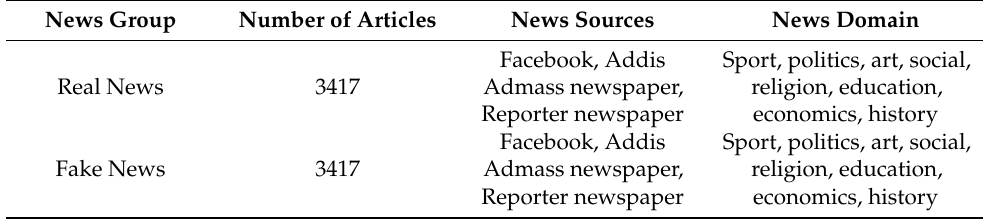
Table 4. Composition of ETH_FAKE: a novel Amharic fake news detection dataset. News Group Number of Articles News